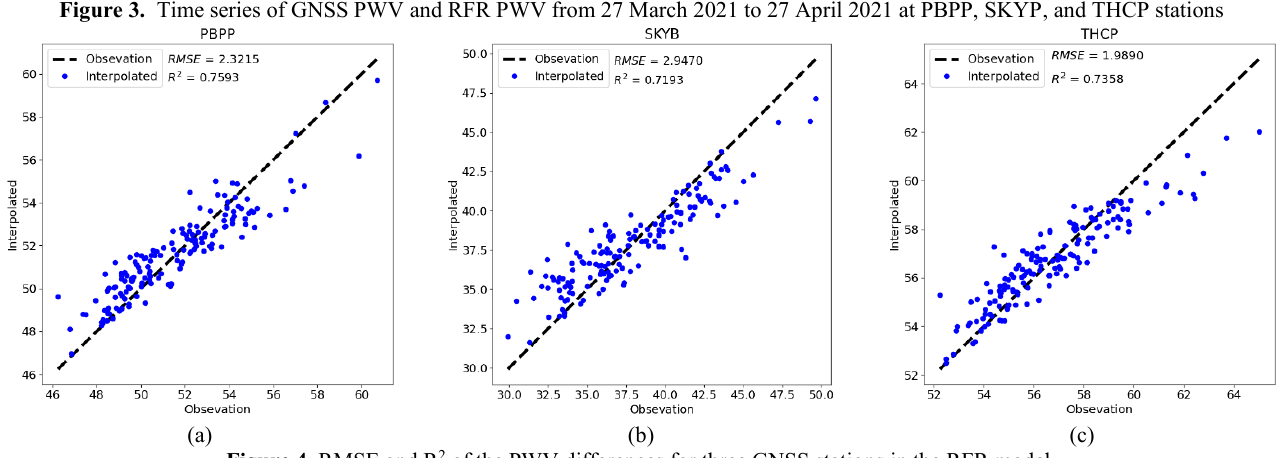
Figure 3. Time series of GNSS PWV and RFR PWV from 27 March 2021 to 27 April 2021 at PBPP, SKYP, and THCP stations